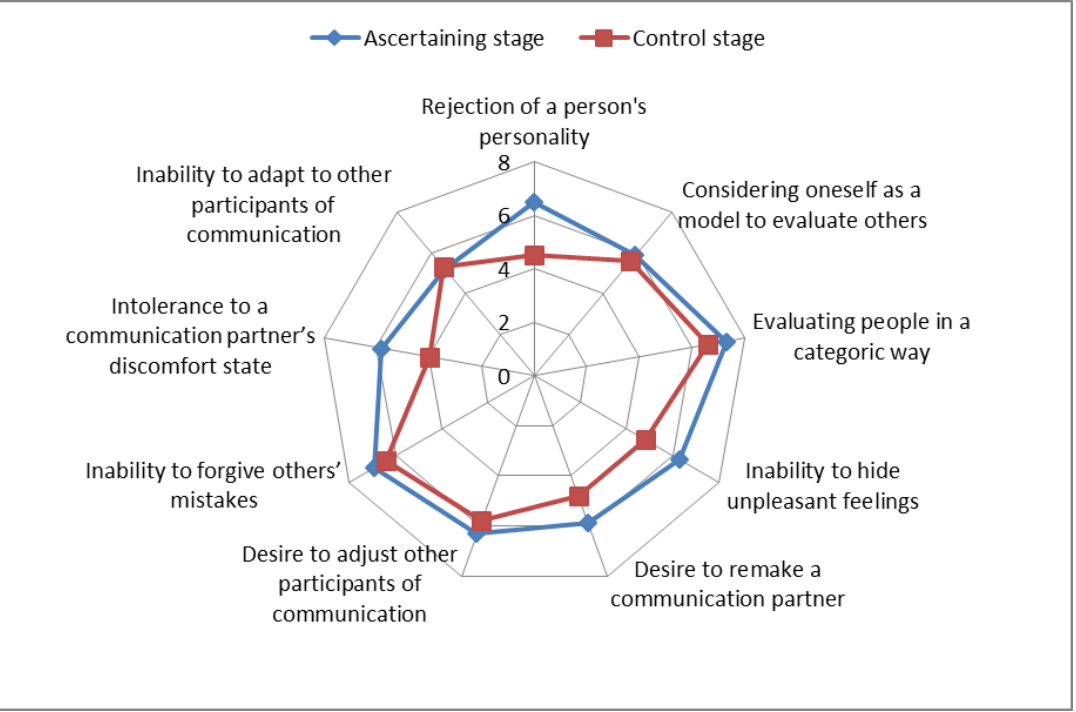
Figure 1. Intolerance average in various aspects of public relations at the ascertaining and control stages of